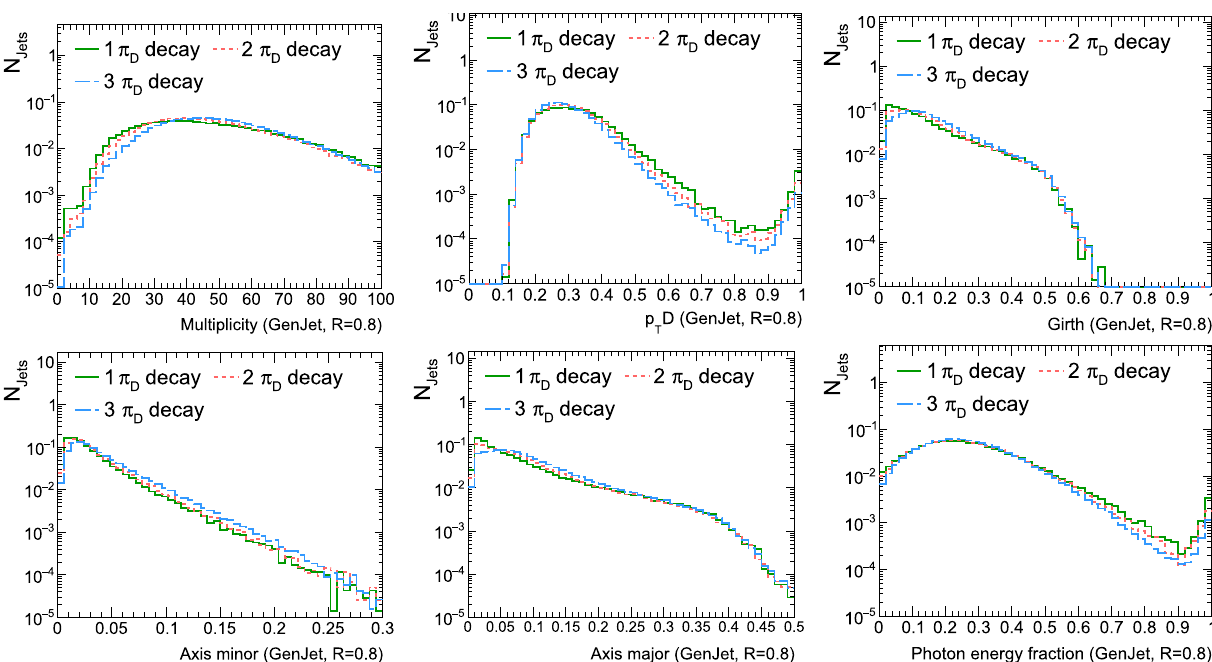
Fig. 44 Comparison between different number of unstable diagonal dark